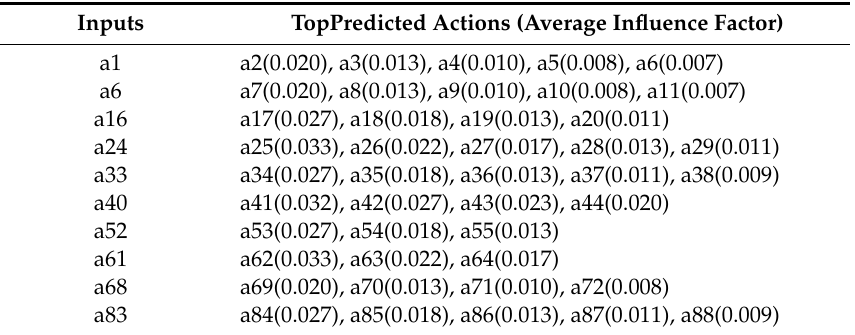
Table 3. Prediction results based on the baseline